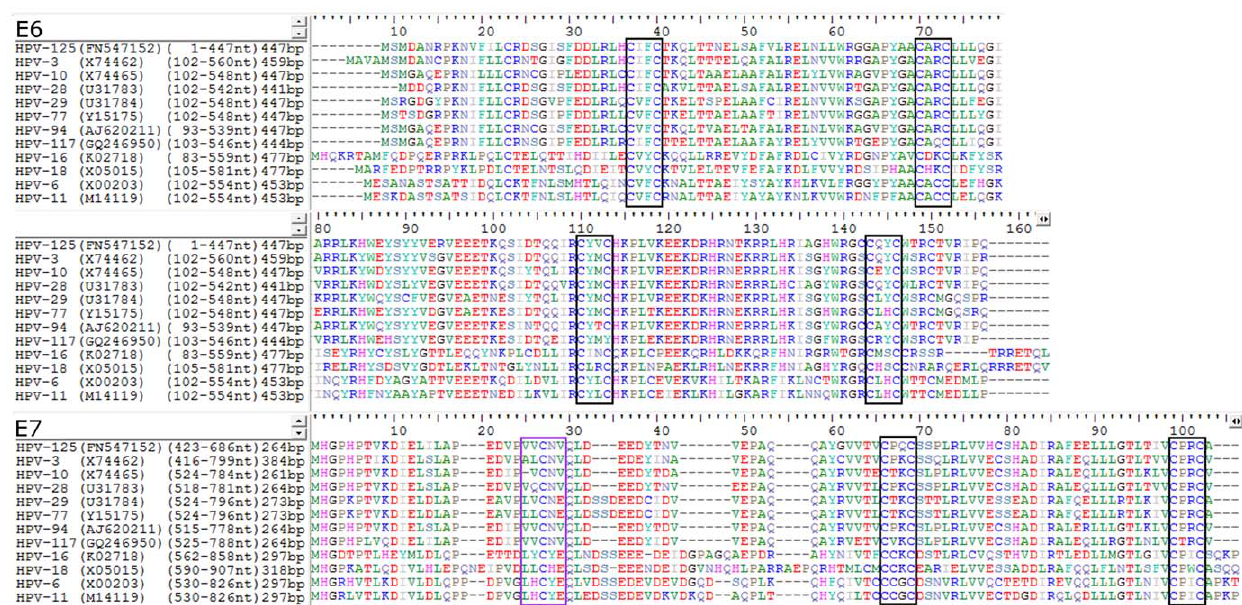
Figure 4. Amino acid alignment of HPV-125 E6 and E7 proteins with corresponding proteins of closely related genotypes from Alphapapillomavirus species 2 and genotypes HPV-16, HPV-18, HPV-6 and HPV-11. Black boxes indicate the location of zinc-binding domains (CxxC(x) 29 CxxC) in both E6 and E7 amino acid alignments. The purple box indicates the location of the pRb-binding core sequence (LxCxE), absent in several Alphapapillomavirus species 2 genotypes [30], including HPV-125.